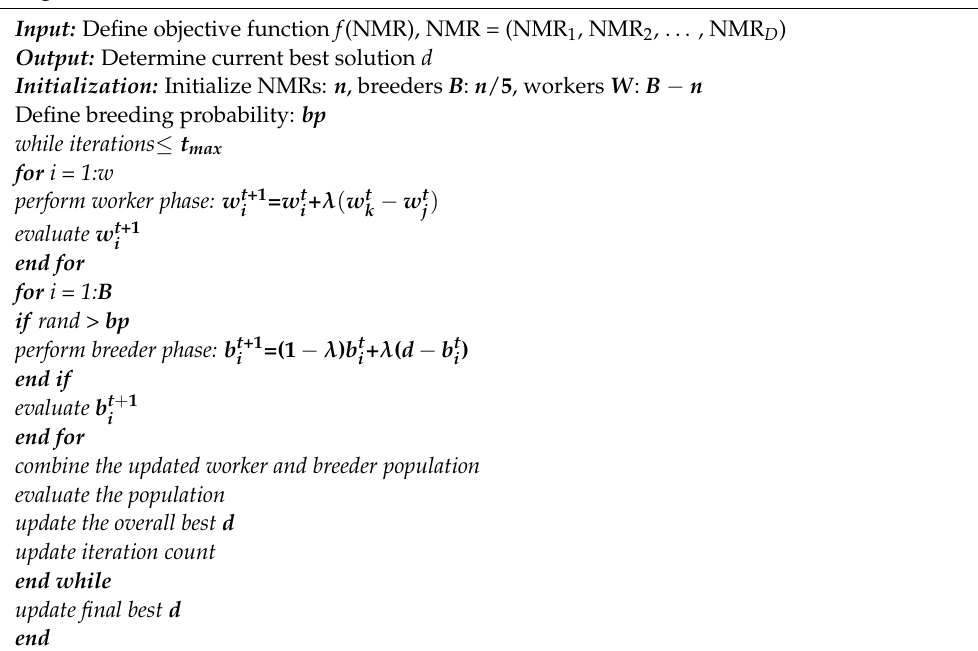
Algorithm 1. Pseudocode of